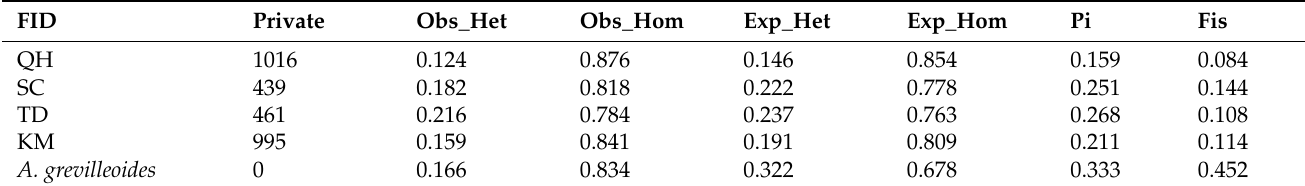
Table 2. Genetic diversity analysis of A. grevilleoides .